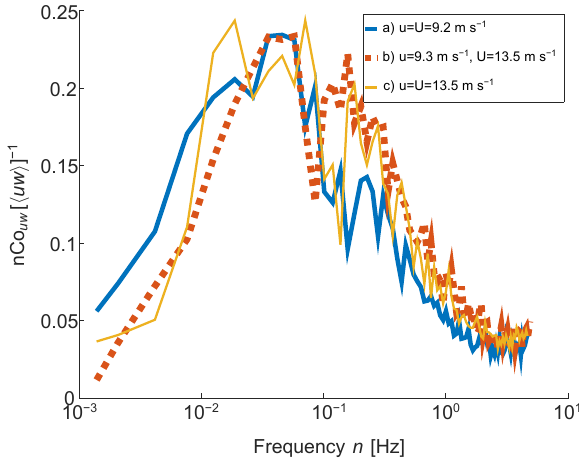
Figure B1. Average normalised cospectra of the momentum- flux (a) station measurements with 8ms − 1 < u 10N < 10ms − 1 , (b) underway measurements with 8ms − 1 < u 10N < 10ms − 1 and a ship’s speed of v obs ≈ 4ms − 1 , and (c) station measurements with 12ms − 1 < u 10N < 14ms − 1 . Only data with relative wind direc- tion | α | < 20 ◦ and z/L < 0 are used.